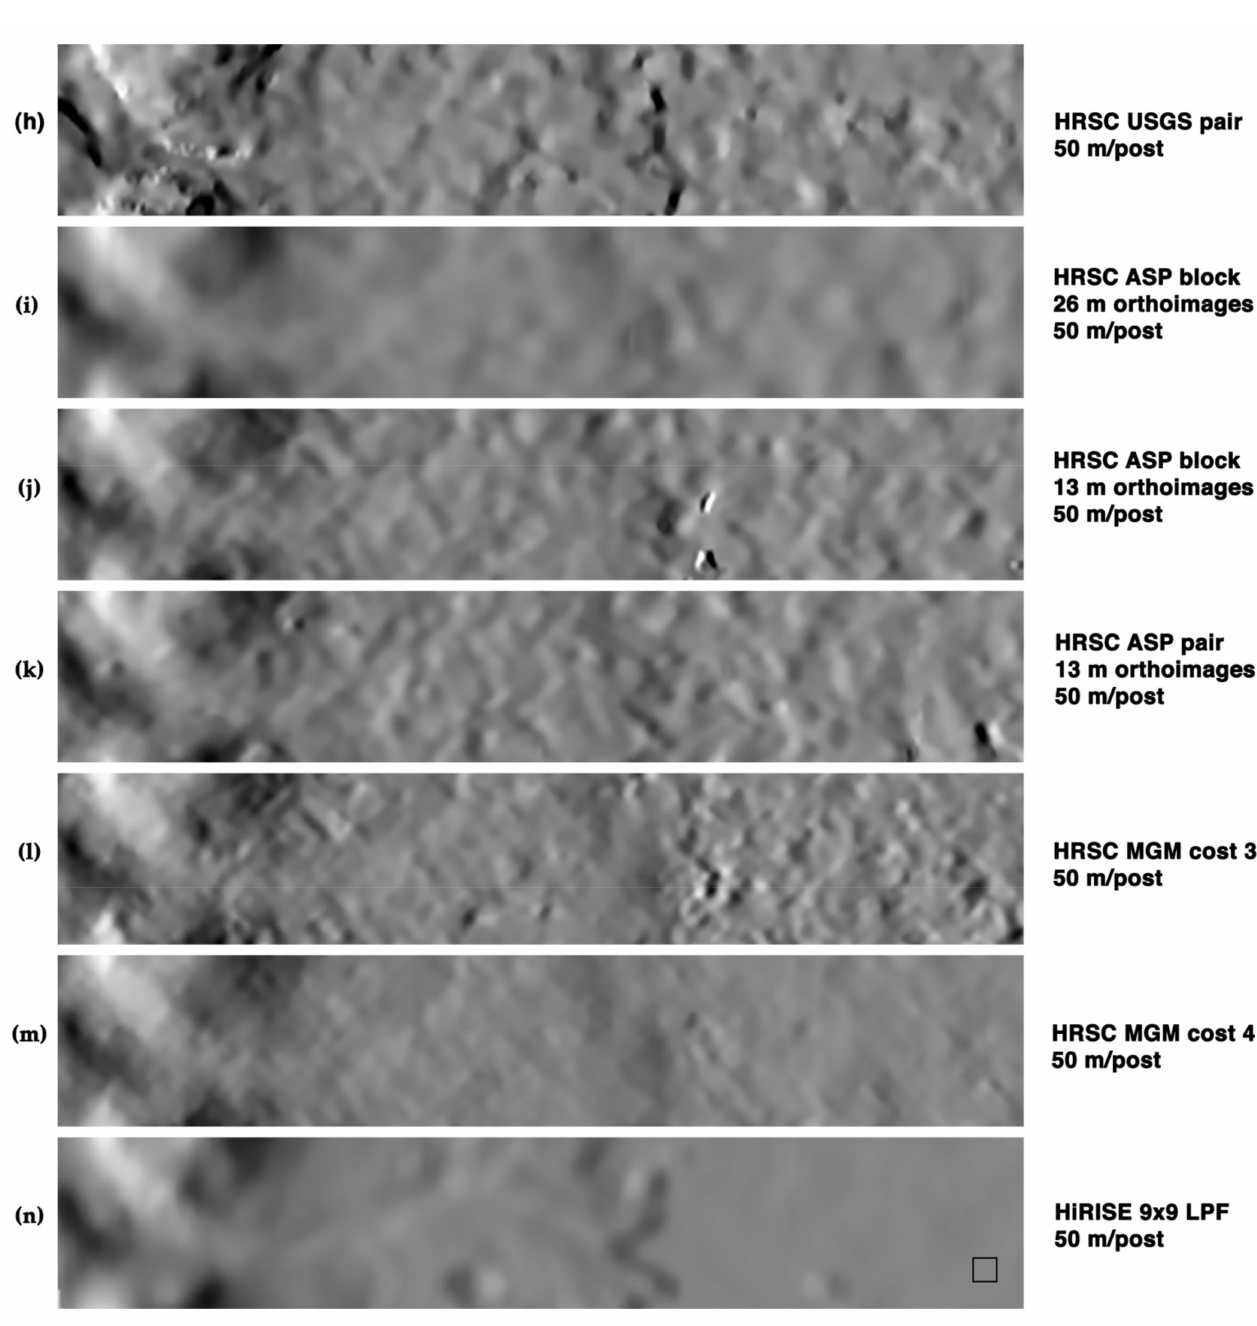
Figure 13. Shaded relief portrayal of Jezero DTMs. ( a ) HiRISE downsampled to 20 m/post. ( b ) CTX at 20 m/post. ( c ) HiRISE at 20 m, smoothed 5 × 5 to match CTX (see Table 1). ( d ) HRSC DLR Level 5. This and the following parts of the figure are all at 50 m/post. ( e ) HiRISE at 50 m/post smoothed 11 × 11. ( f ) HRSC USGS. ( g ) HiRISE at 50 m/post, smoothed 7 × 7. ( h ) HRSC USGS, based on stereo channels only; compare to result f with stereo and nadir. ( i ) ASP block matcher (best kernel sizes). ( j ) ASP block matcher, nadir and stereo channels orthorectified at nadir GSD. ( k ) ASP block matcher, stereo channels only, orthorectified at nadir GSD. ( l ) ASP MGM cost mode 3. ( m ) ASP MGM cost mode 4. ( n ) HiRISE at 50 m/post, smoothed 9 × 9, best reference for DTMs h–l. Best reference form is HiRISE with 11 × 11 smoothing ( e ). All images 18 × 3.2 km, centered at 77.4 ◦ E, 18.5 ◦ N, Simple Cylindrical projection, north at top, latitude of true scale 18.6 ◦ N, illuminated from left with identical contrast stretch. HRSC products have been enlarged to aid comparison. Squares in panels ( c , e , g , n ) indicate the size of smoothing filter applied to HiRISE to match target DTM resolution. The largest crater is Belva, diameter 900